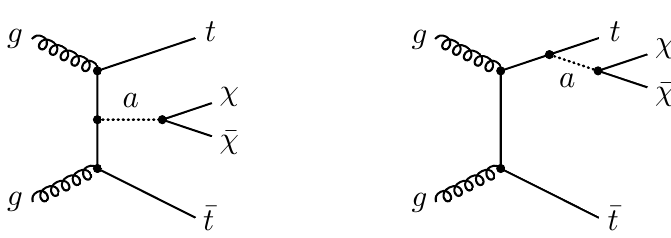
Figure 8 . Two possible diagrams that give rise to a t (cid:22) t + E T; exchange of an a and A contribute in the THDM plus pseudoscalar extensions but only the former are